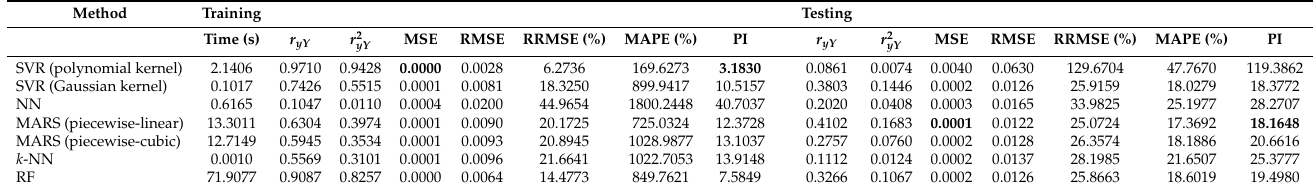
Table 11. Performance of the machine learning in carbon prediction based on static data (lime and dolomitic lime added as supplementary observations).